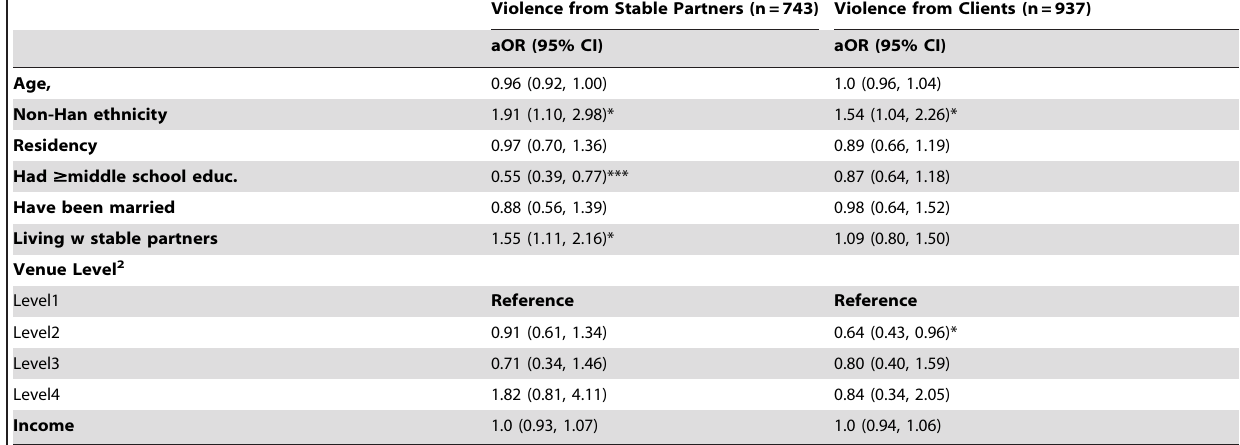
Table 2. Multivariate logistic regression of partner violence on key demographic characteristics 1 .